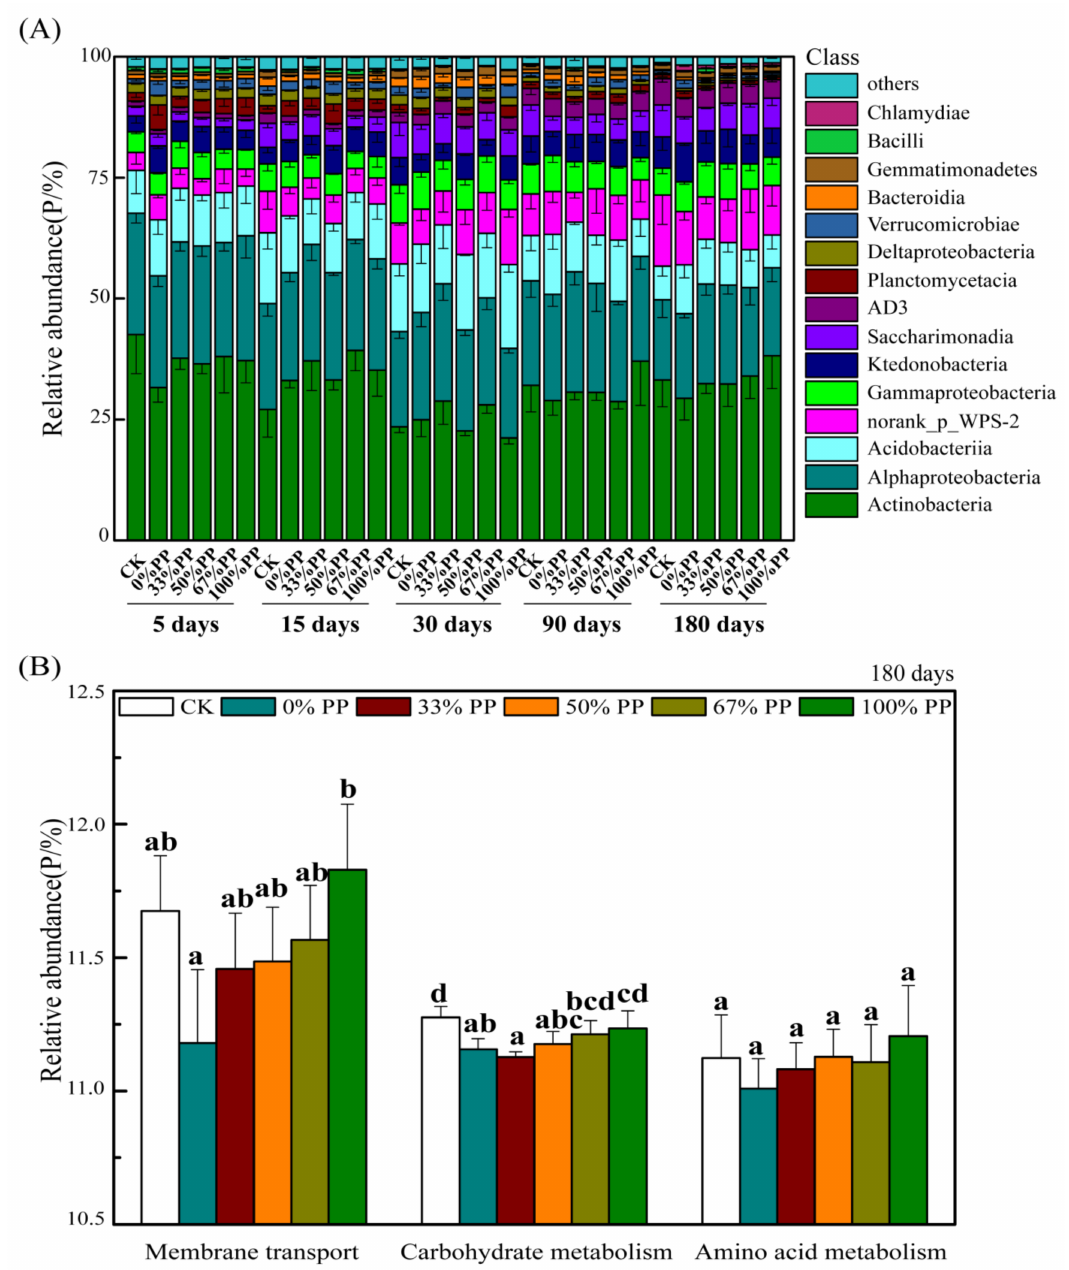
Figure 1. The community composition ( A ) and functional pathways ( B ) of bacteria at the level of class in the broadleaved forest soil during incubation. CK, with no litter; 0% PP, bamboo litter occupying at 0%; 33% PP, bamboo litter occupying at 33%; 50% PP, bamboo litter occupying at 50%; 67% PP, bamboo litter occupying at 67%; 100% PP, bamboo litter occupying at 100%. Bars with different letters among different treatments are significantly different ( p <